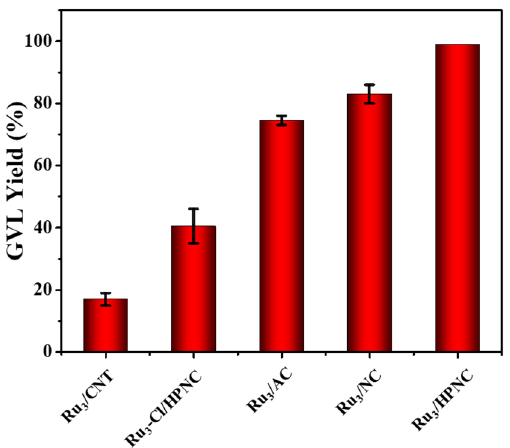
Figure 5. Catalysts with different supports in the hydrogenation of LA. Reprinted with permission from Ref. [31]. Copyright © Elsevier Inc. 2022.